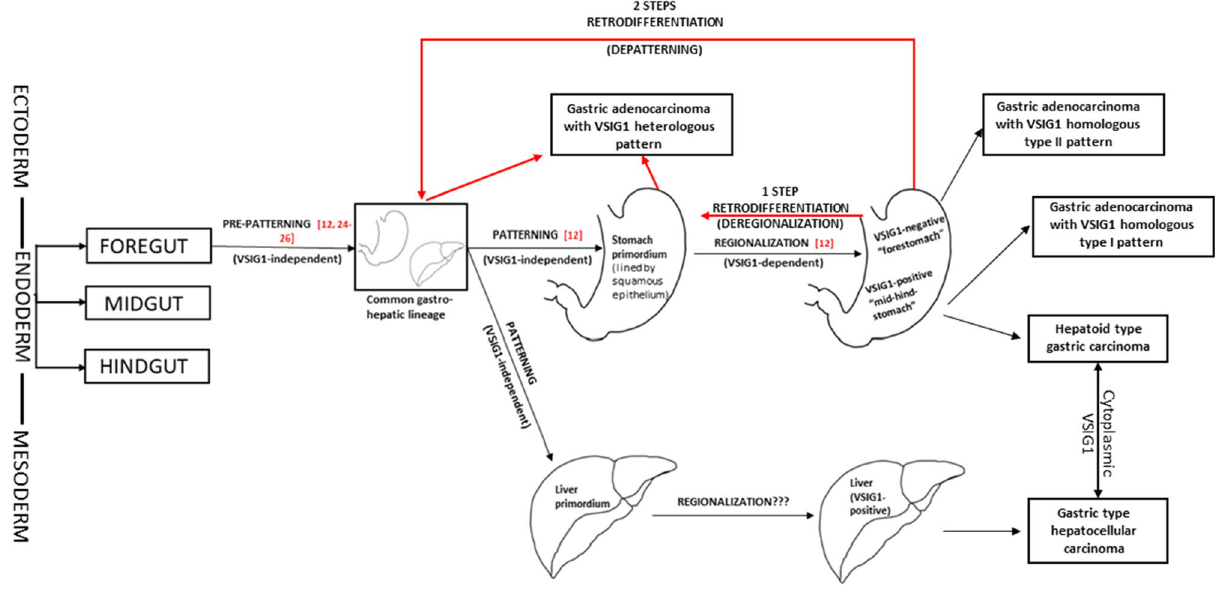
Figure 6. VSIG1-related theory of gastric tumorigenesis—designed based on own data and information from papers of Oidovsambuu et al. 12 and Gurzu et al. 18